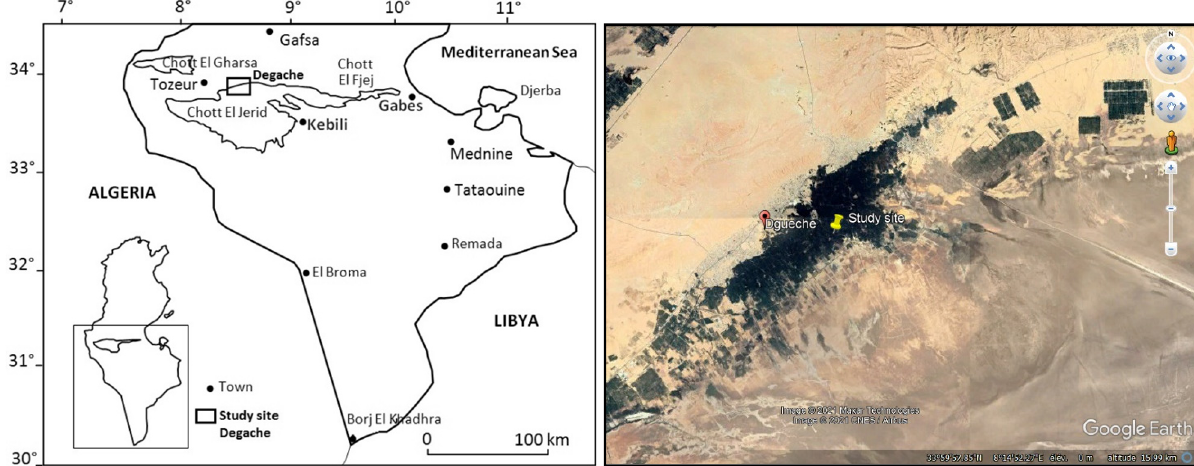
Figure 1. Location of the study site.